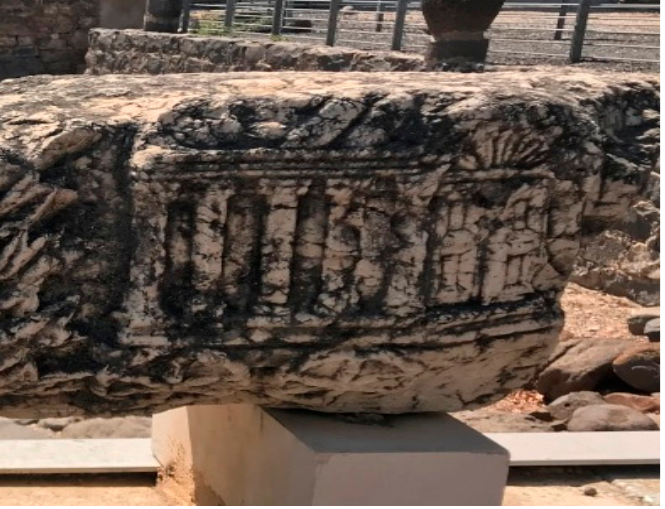
Figure 3. Torah Shrine on Wheels, from fifth/sixth-century synagogue in Capernaum. Photo by author.